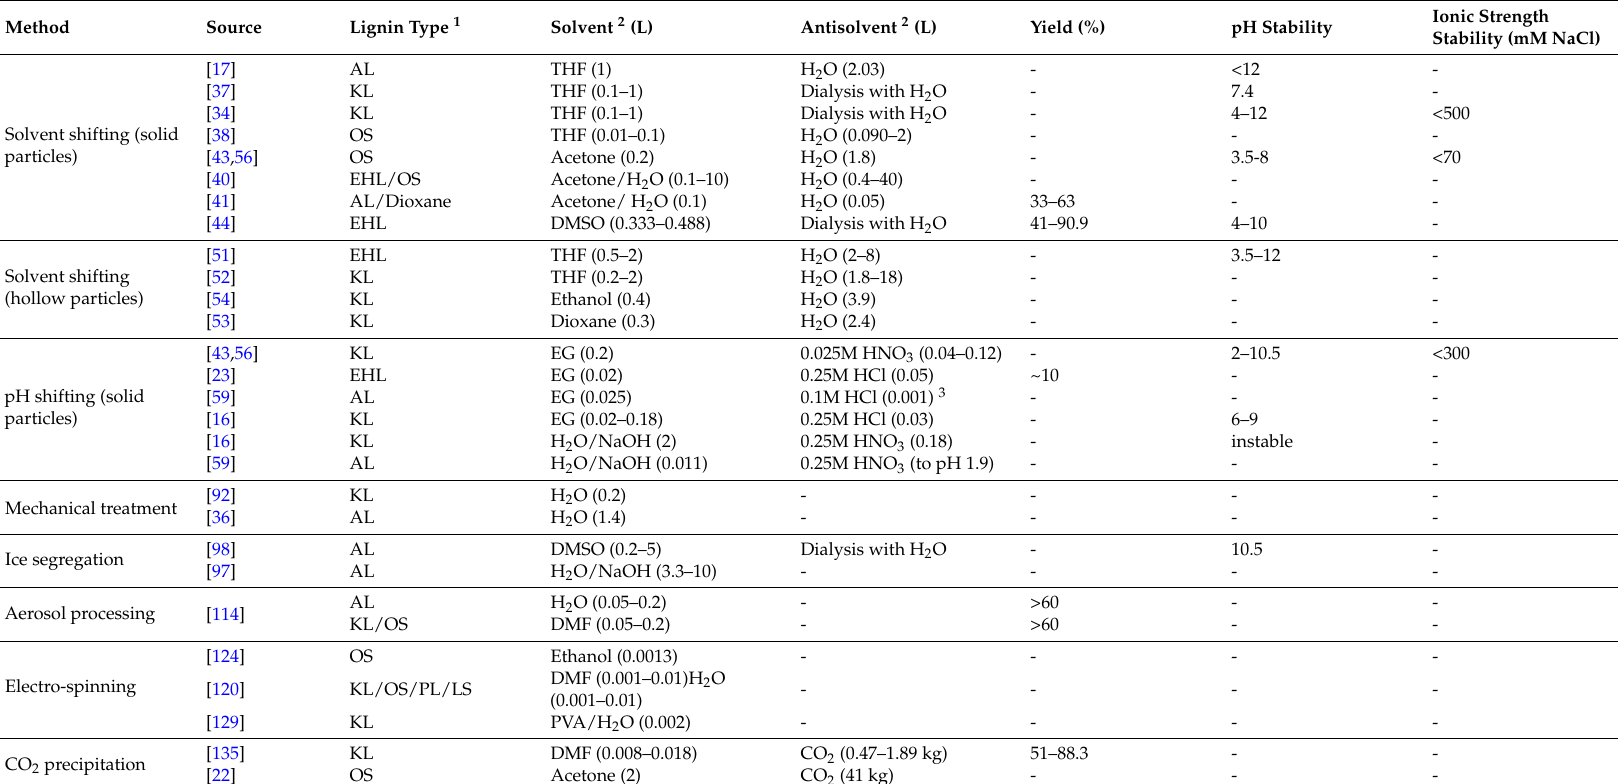
Table 3. Comparison of investigated methods in terms of lignin type, solvent and antisolvent consumption, yield and stability at different pH and ionic strength